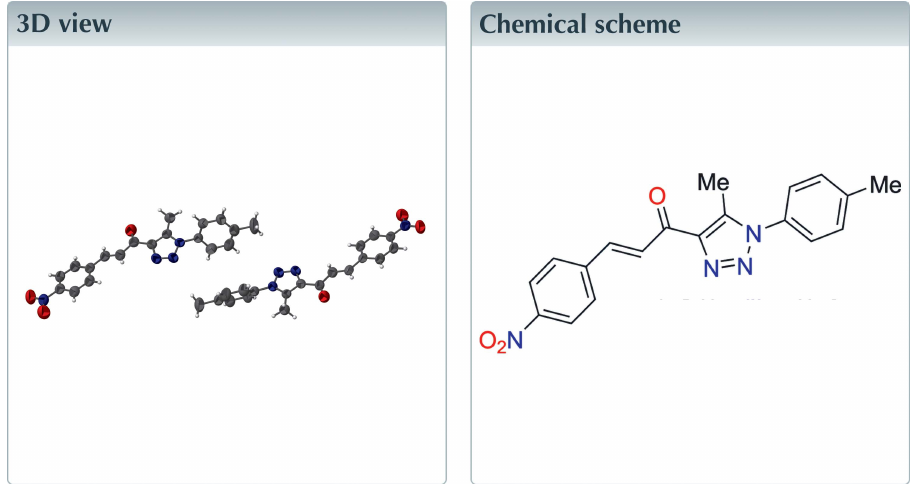
chains (Table 1). Weak C—H (cid:3) (cid:3) (cid:3) (cid:2) and N—O (cid:3) (cid:3) (cid:3) (cid:2) contacts (Table 1, Fig. 2) may help to consolidate the